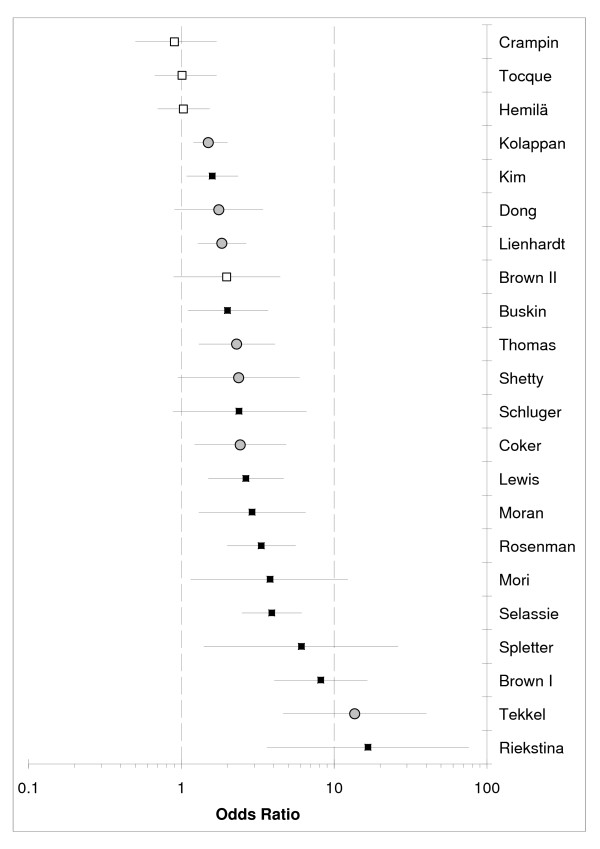
Forest plot of all 21 studies. Bars indicate 95% confidence interval. Filled squares represent point estimate for studies in the high exposure/alcoholism category, white squares represent studies in the low exposure category, and grey circles studies that did not report a well-defined exposure level.